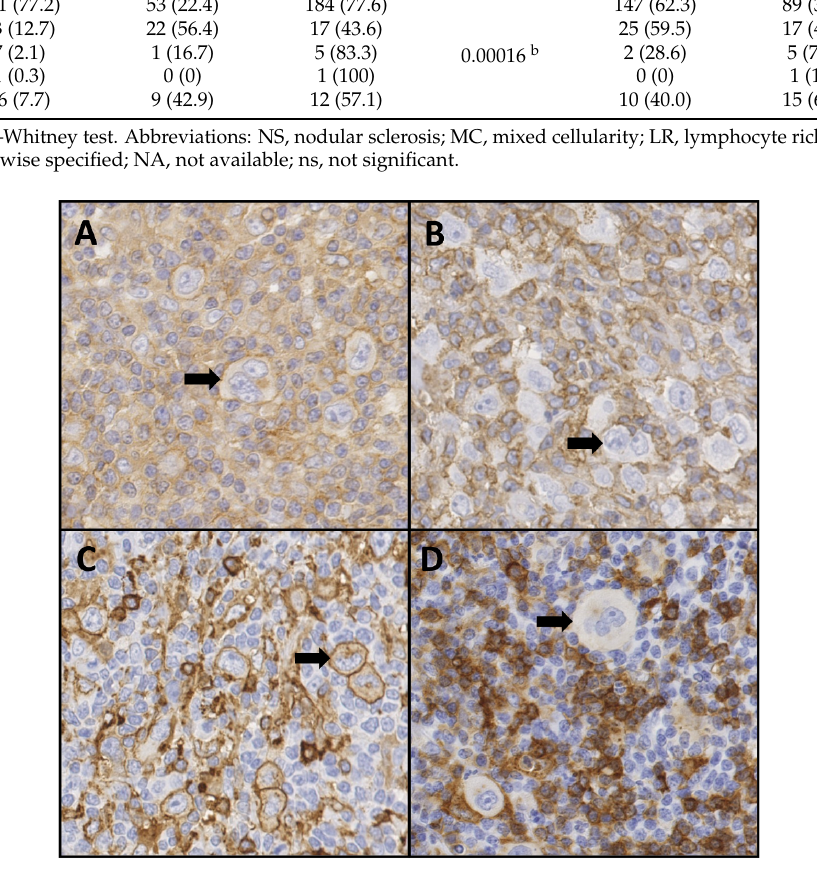
Figure 1. Representative images of immunohistochemistry staining for B2M and HLA class II in classic Hodgkin lymphoma tissue. Scoring is based on staining of the cell membrane of Hodgkin and Reed Sternberg cells. ( A ) B2M positive, ( B ) B2M negative, ( C ) HLA class II positive, ( D ) HLA class II negative. Arrows indicate representative HRS cells. 40 × Table 1. Patient characteristics in total and HRS cell HLA expression status stratified subgroups.